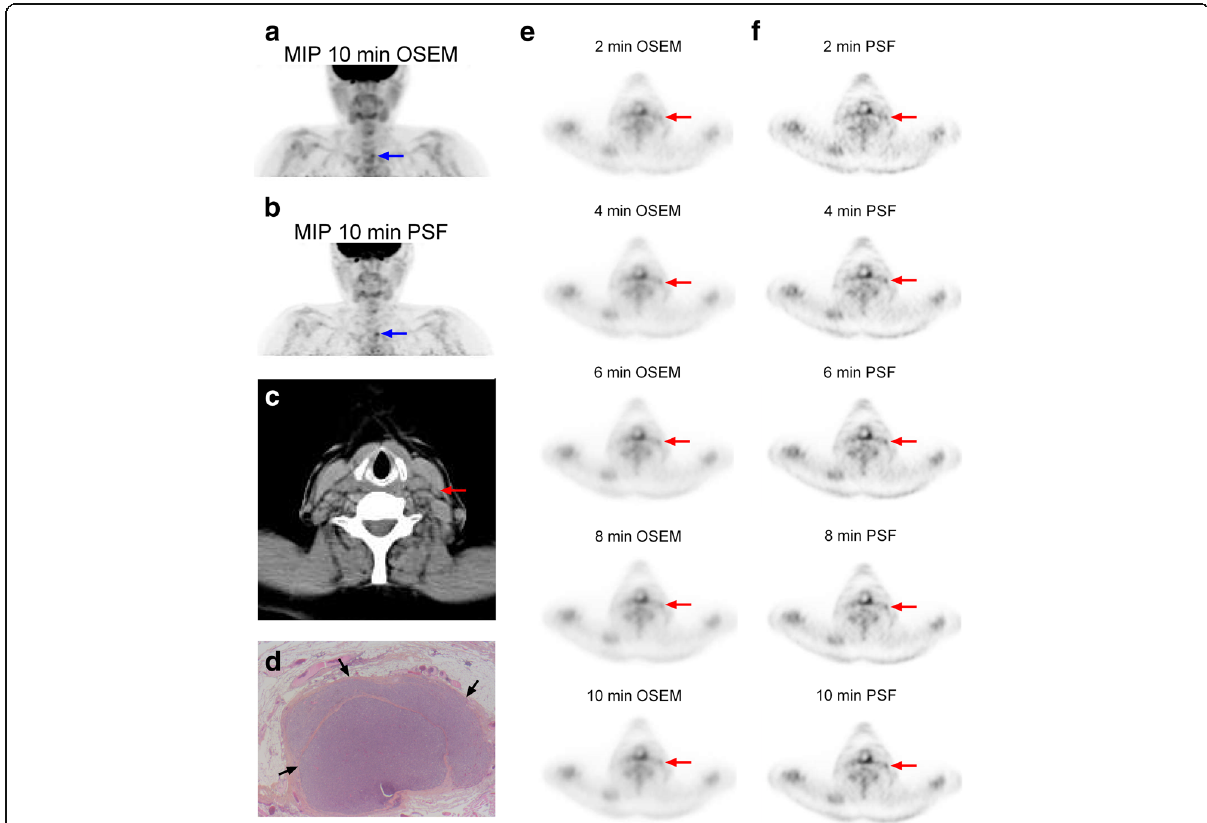
Fig. 6 A 62-year-old female patient with a 70-mm PDTC (pT3 Nx Mx) was referred for 18 FDG PET/CT in November 2017 to explore a detectable serum Tg level under levothyroxine (11 ng/ml, without serum TgAb) 2 years after initial 131 I treatment. Maximum intensity projection images (MIP) showed lymph node involvement of the left central compartment on both 3D-OSEM-reconstructed HN PET ( a , blue arrow) and PSF allpass - reconstructed HN PET ( b , blue arrow). No abnormal 18 FDG focus (score ≤ 3) was reported on 3D-OSEM-reconstructed HN PET in the left lateral compartment (at 10 min: SUVmax = 1.67, TBR = 1.19) ( e ). On the PSF allpass -reconstructed HN PET data sets ( f ), a small focal 18 FDG uptake in the left lateral compartment was scored as probably malignant (score 4) at 4 – 10 min (at 10 min: SUVmax = 2.43, TBR = 1.74), corresponding to a 6 × 4 mm lymph node on CT scan ( c , red arrow). Left central and left lateral dissection was performed and confirmed lymph node involvement in both compartments. d The left lateral lymph node was massively invaded (black arrows). The size of the tumour deposit was 5 mm (HES staining, ×